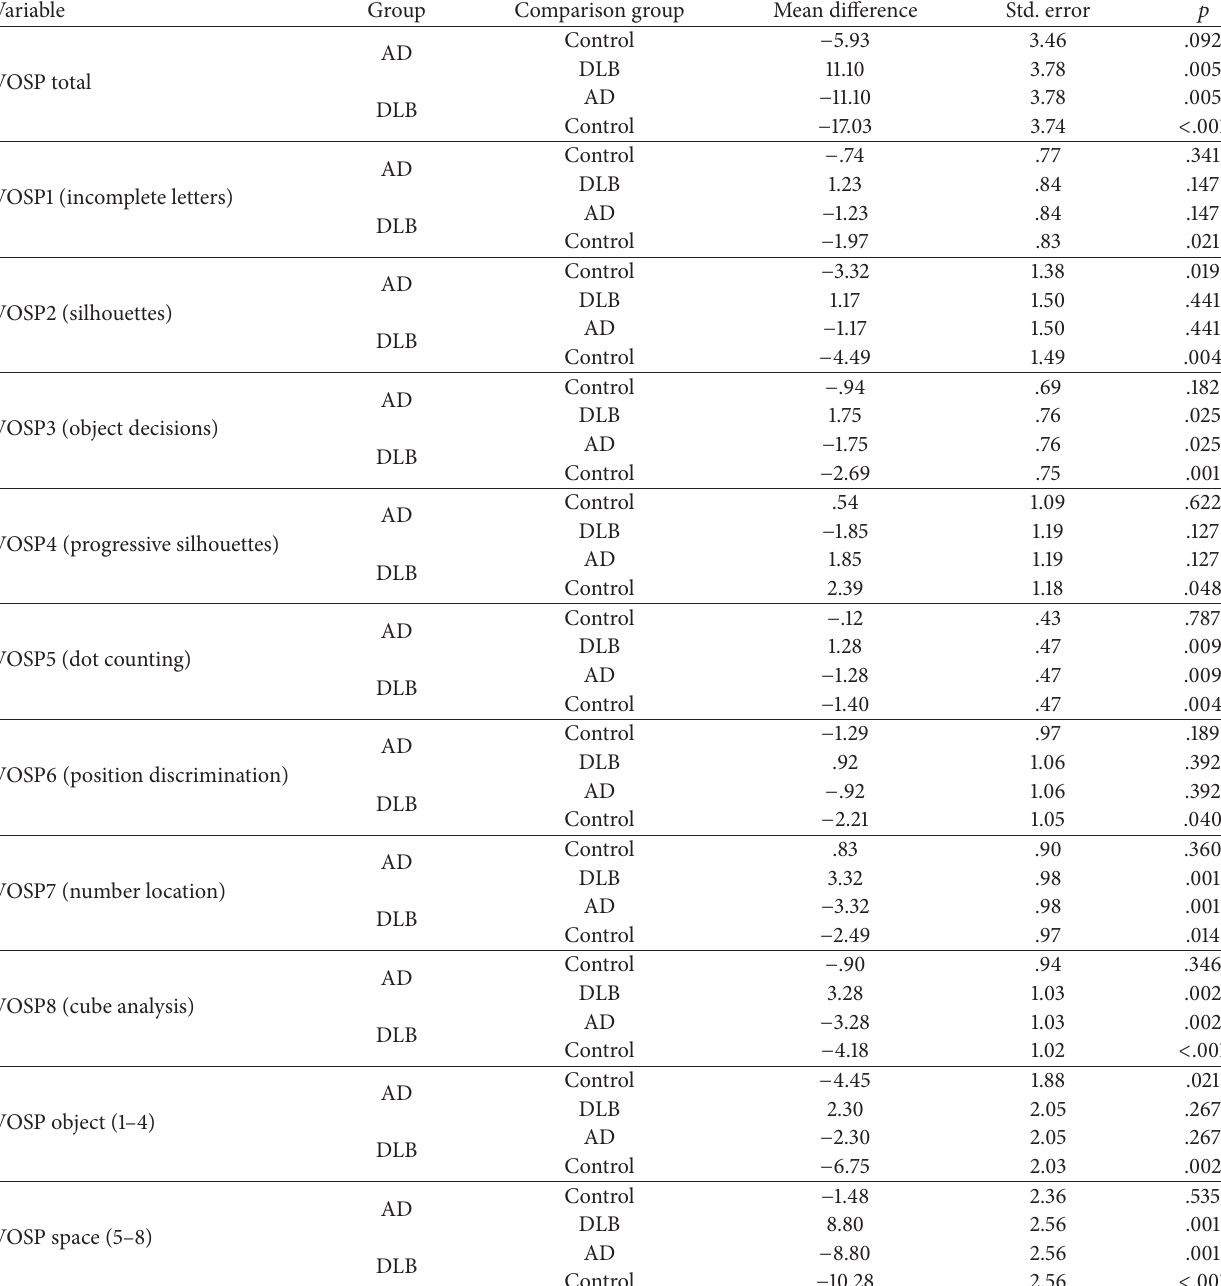
Table 4: Post hoc group comparisons (i.e., control, DLB, and AD) on measures of visuospatial/perceptual abilities.